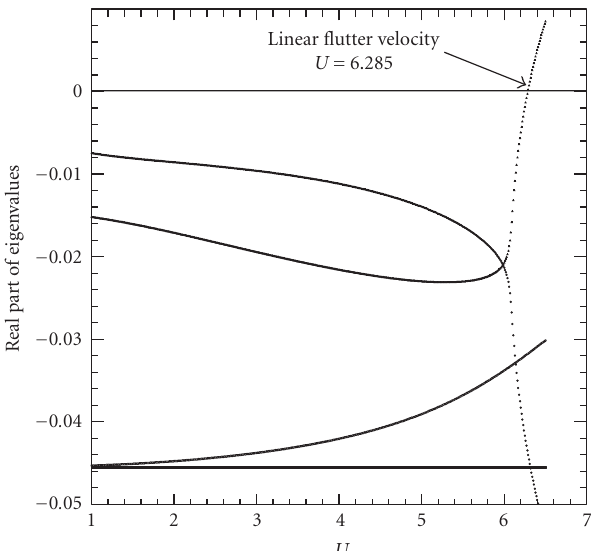
Figure 2: The real part of the eigenvalues as a function of U for the linearized